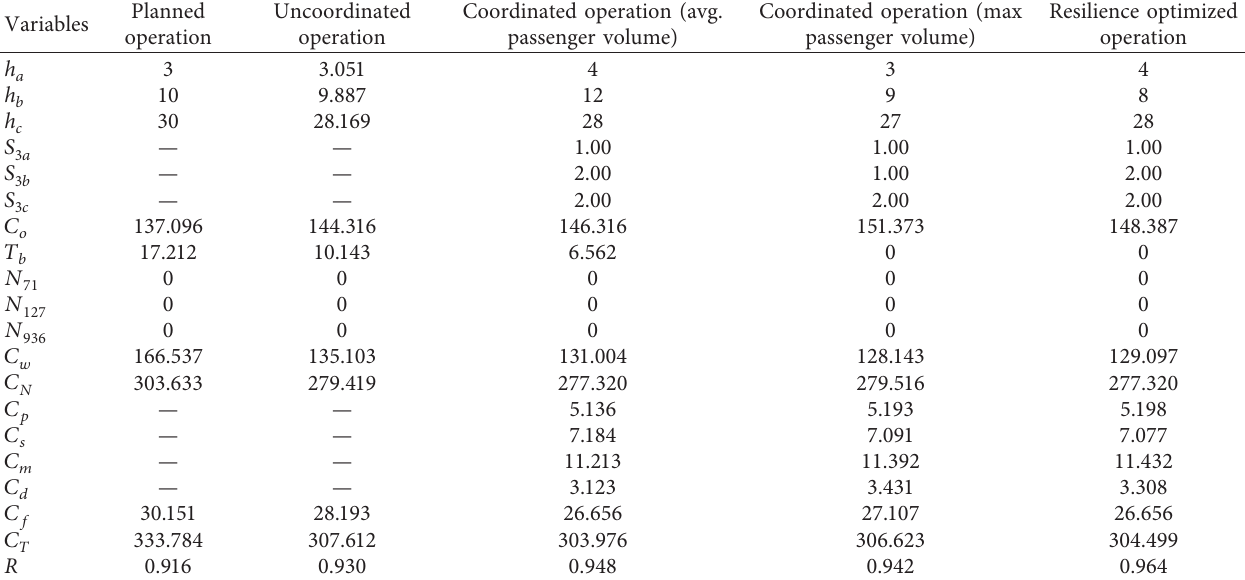
Table 2: Comparison of different operation methods at average passenger flows.